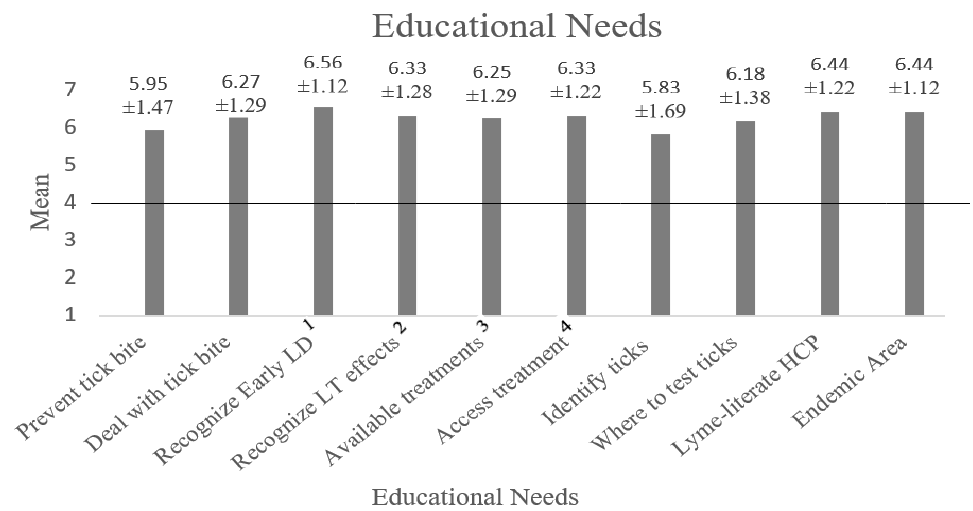
Figure 3. The self-reported educational needs of individuals that spend a lot of time outdoors. 1 How to recognize Lyme disease in the first days of infection. 2 How to recognize the long-term effects of Lyme disease. 3 Lyme-literate HCP = where to find health care providers who are knowledgeable about Lyme disease. 4 Endemic Area = how to find out if an area contains many ticks infected with Lyme disease.